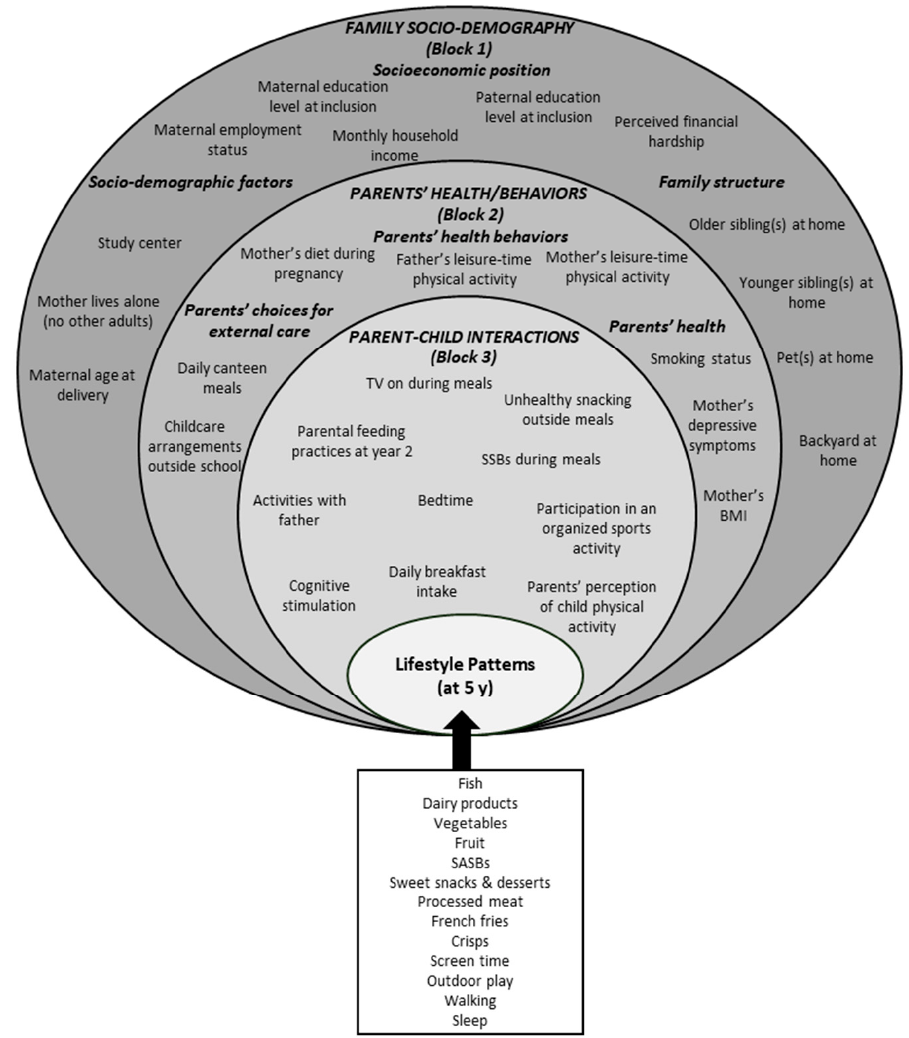
Figure 1. Conceptual framework of family contextual factors potentially associated with year ‐ 5 life ‐ style patterns in the EDEN study. If not otherwise stated, factors were collected at year 5. BMI: Body mass index; SASBs: Sugar or artificially sweetened beverages; y: years.